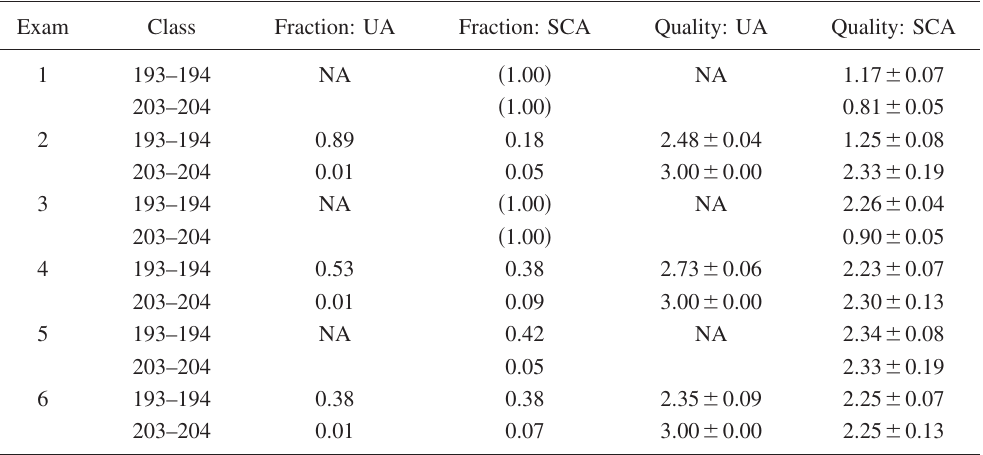
TABLE I. Measurements of students’ evaluative abilities for unit analysis (cid:1) UA (cid:2) and special-case analysis (cid:1) SCA (cid:2) on each of the six